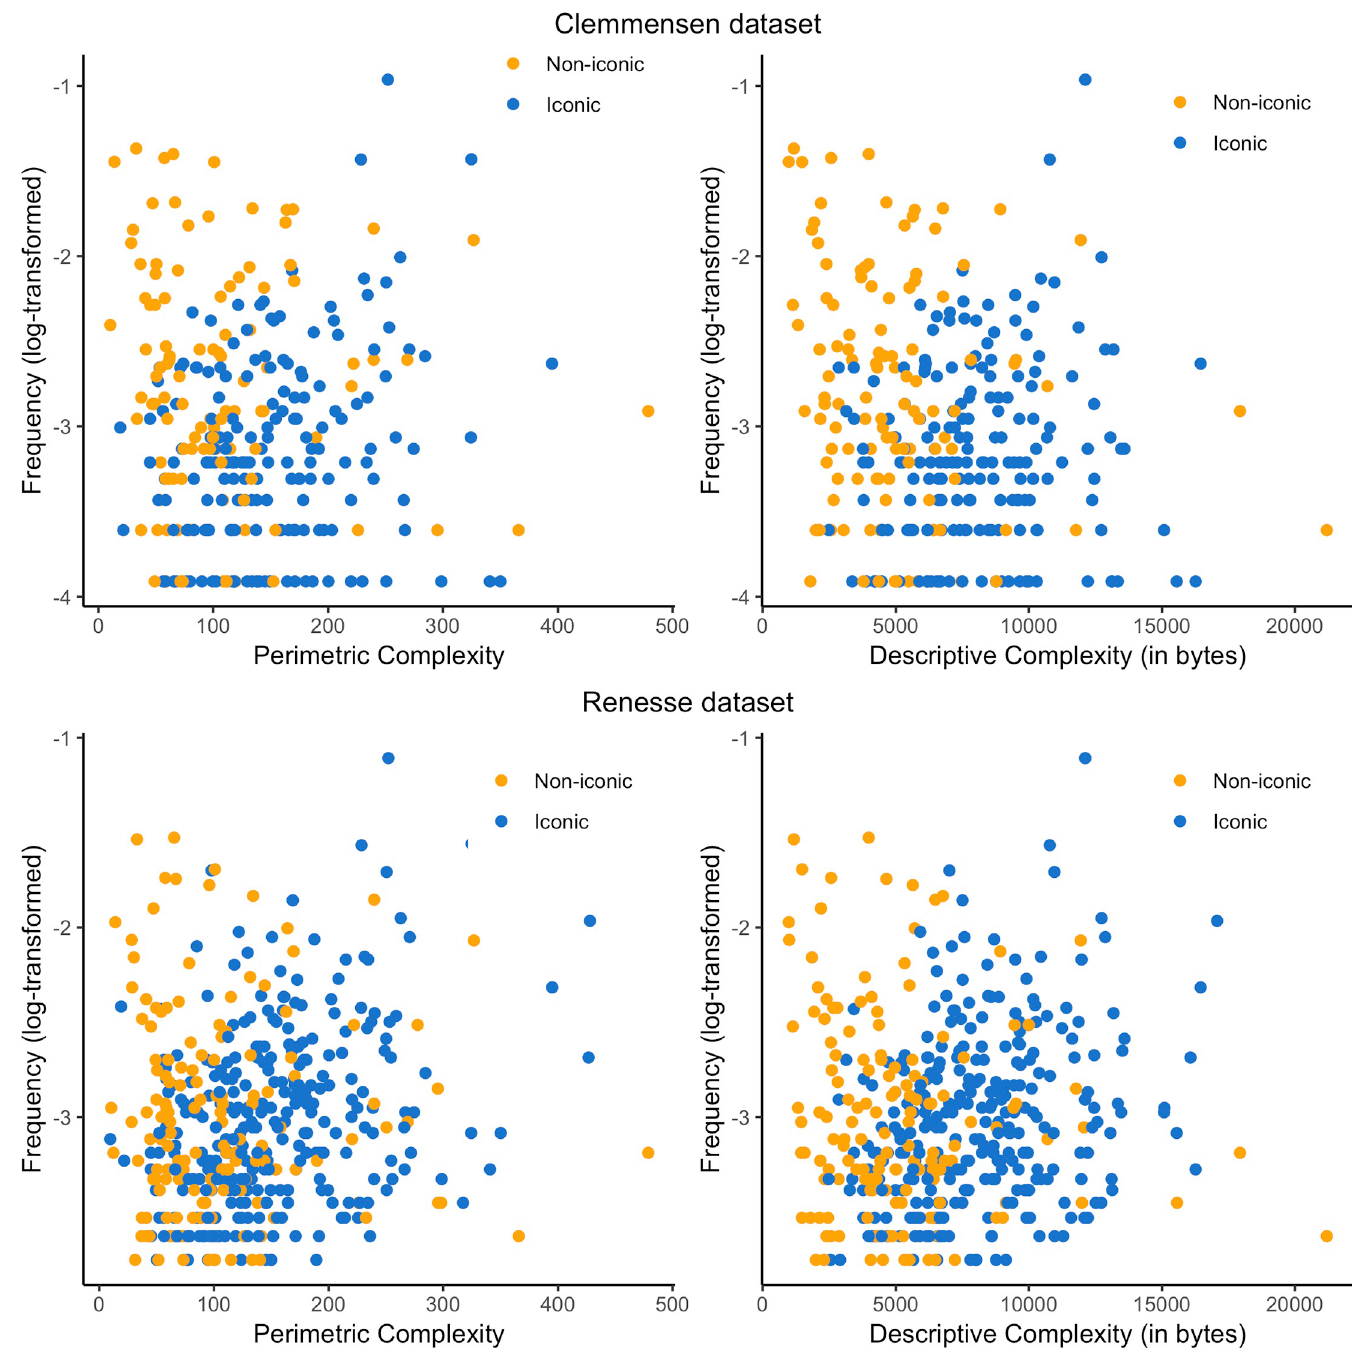
Fig 4. Frequency (log-transformed) as a function of perimetric complexity (left) and descriptive complexity (right), for both corpora (Clemmensen above, Renesse below). Color indicates iconicity—i.e., iconic motifs are in blue and non-iconic motifs are in orange.